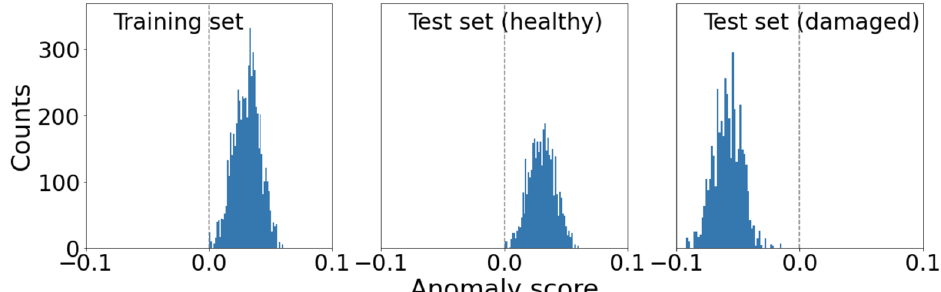
Figure 7. Anomaly detection based on anomaly scores computed with the isolation forest algorithm. The training set contains only spectra from healthy component states, corresponding to the absence of anomalies as indicated by a positive anomaly score ( left panel ). We tested the model using additional spectra from healthy component states ( middle panel ) and from damaged component states ( right panel ). In the latter case, the anomaly scores were negative, indicating anomalies as expected. Healthy and damaged components are clearly separable with this approach.